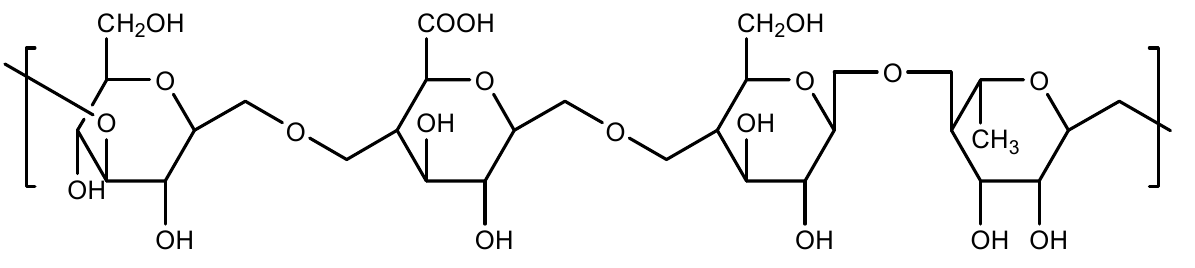
Figure 1. Molecular structure of gellan gum.